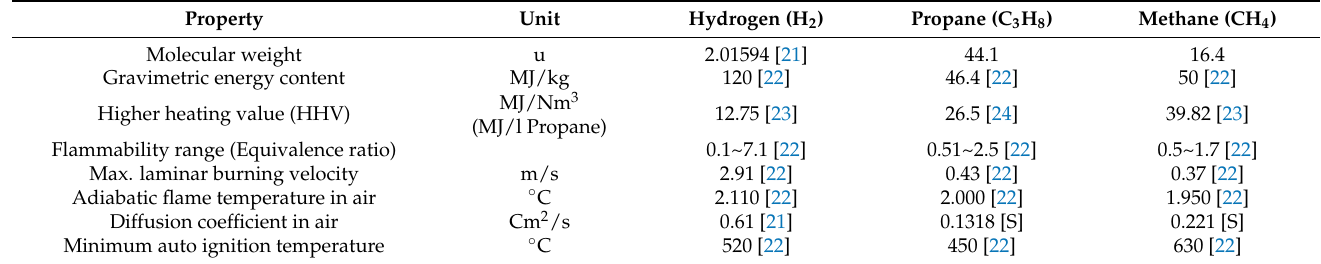
Table 1 comprises selected properties of hydrogen, propane and methane as reference gases. Since LPG consists of >95% propane, propane approximately reflects the properties of LPG. Table 1. Selected properties of hydrogen, propane, and methane. As the main compound of LPG and natural gas, the properties of propane and methane approximate LPG and natural gas properties, respectively. Originally published in